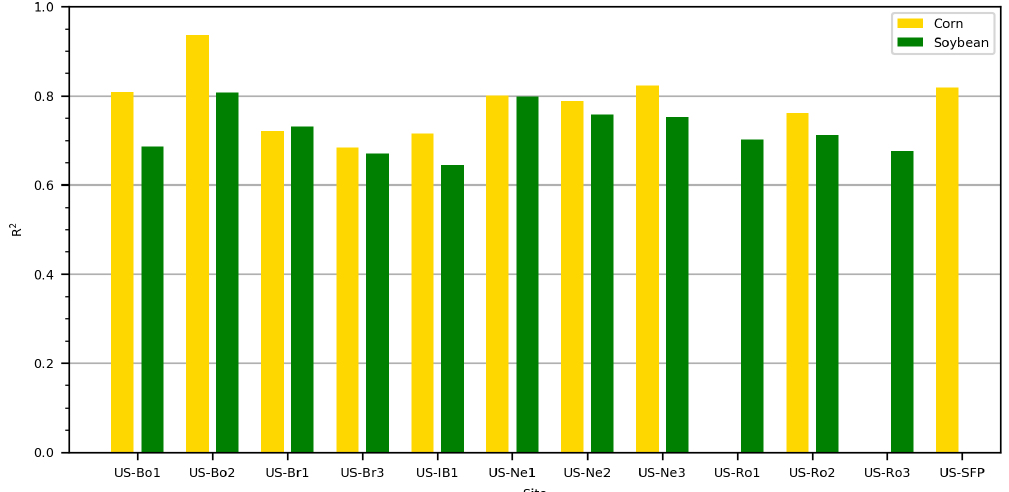
Figure 5. Site-by-site R 2 between flux tower measured and BESS-STAIR estimated daily ET for corn and soybean, respectively. Crop type is from CDL